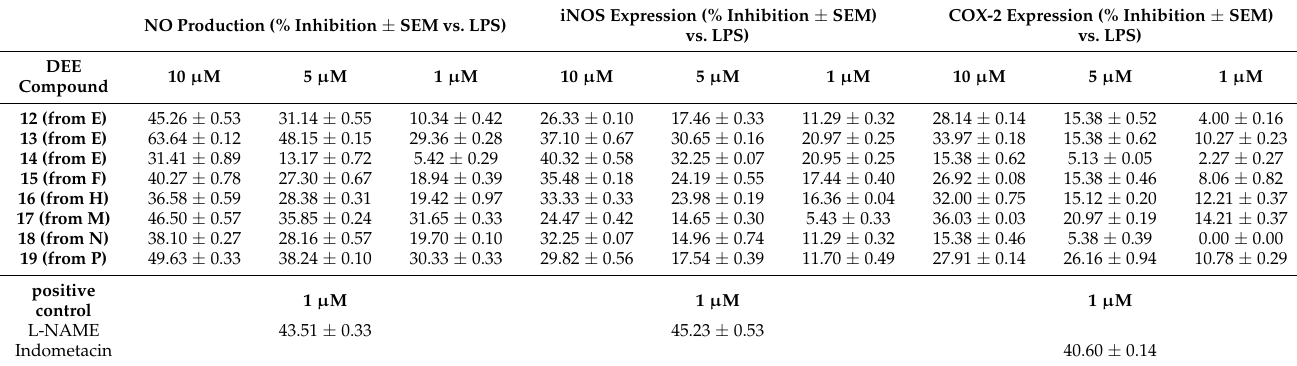
Table 2. NO production inhibition and iNOS and COX-2 expression inhibition vs. LPS ± SEM ( n = 3) of compounds 12 – 19 from the DEE fraction of the methanolic extract of C. articulatus at 10, 5, and 1 µ